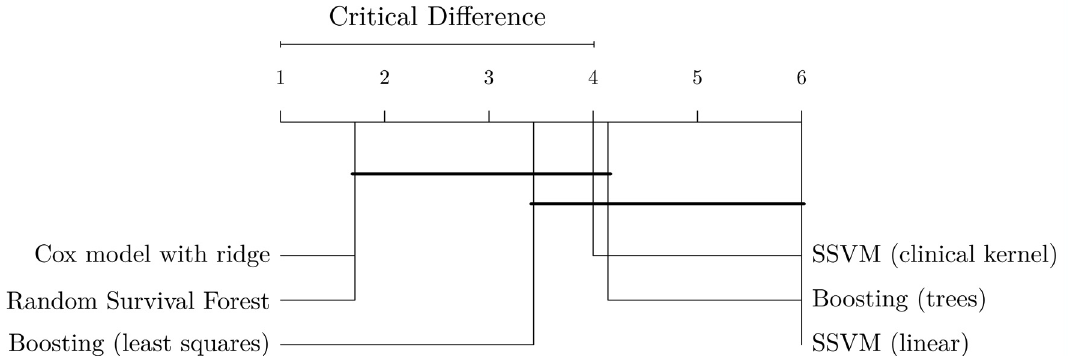
Figure 4. Comparison of methods based on experiments in Figure 2 with the Nemenyi post-hoc test 34 . Methods are sorted by average rank (left to right) and groups of methods that are not significantly different are connected ( p -value